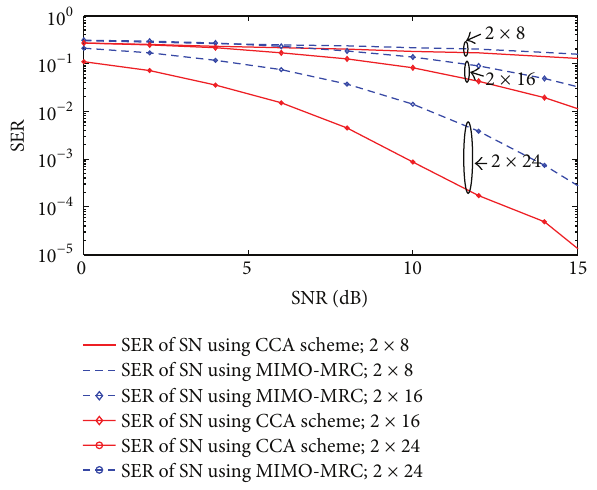
Figure 2: SER performance of SN using CCA and MIMO-MRC schemes for 𝐽 𝑠𝑝 = −15 dB.